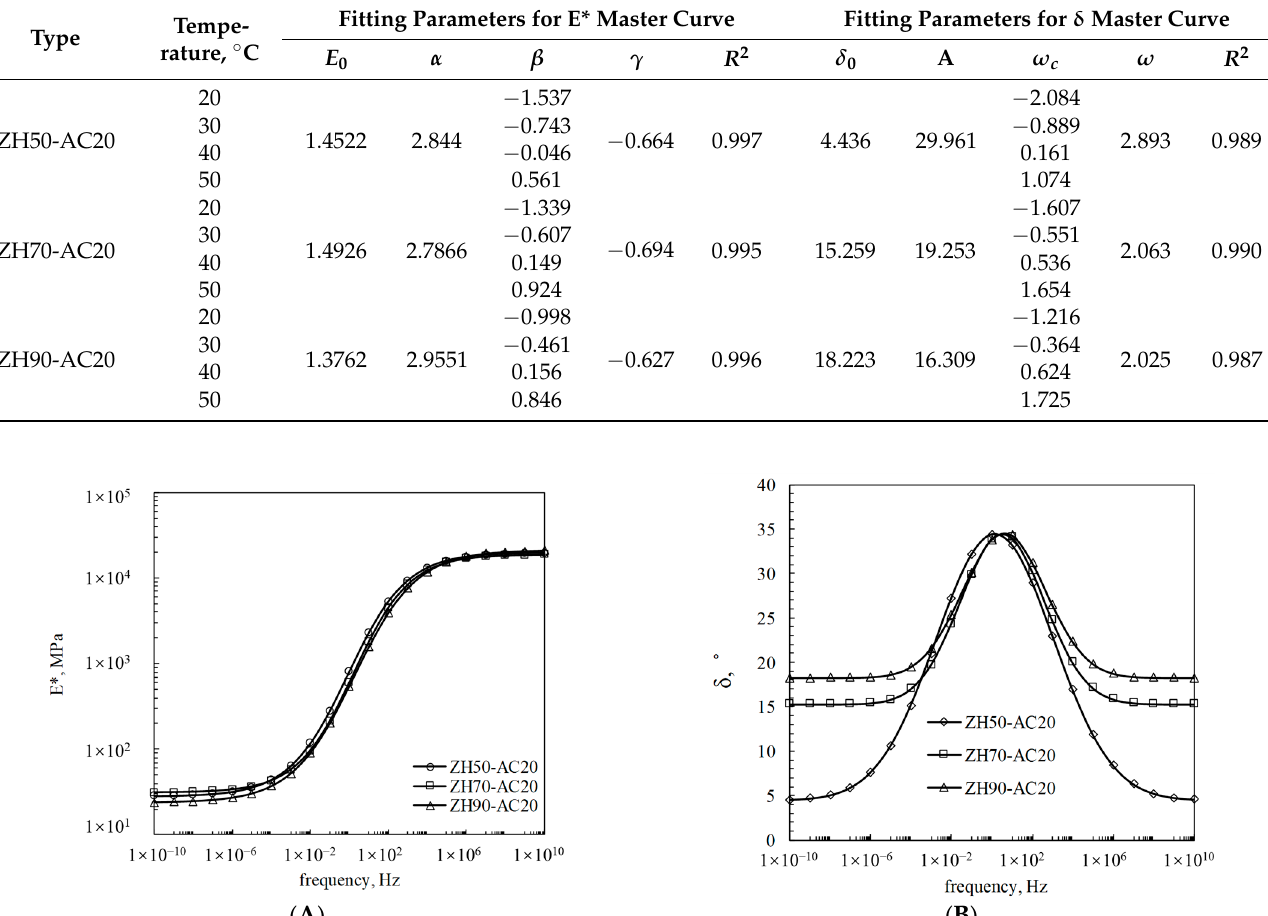
Table 2. Master curve parameters for three asphalt mixtures.